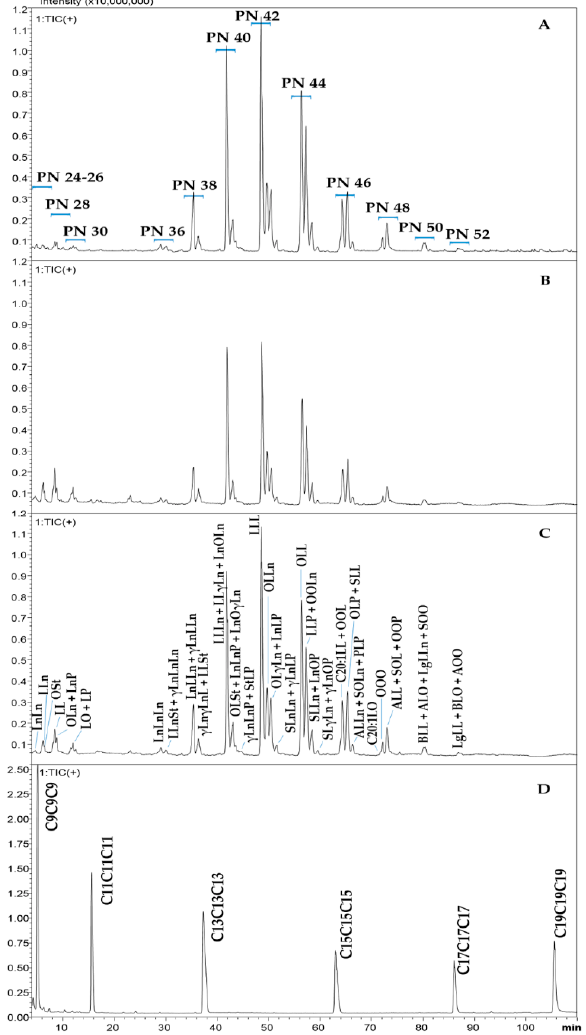
Figure 3. LC-MS profiles of ( A ) hempseed oil IV, ( B ) hempseed flour IV, ( C ) flour residue IV and ( D ) reference homologue series. PN is the partition number of lipid species. Fatty acid abbreviations: